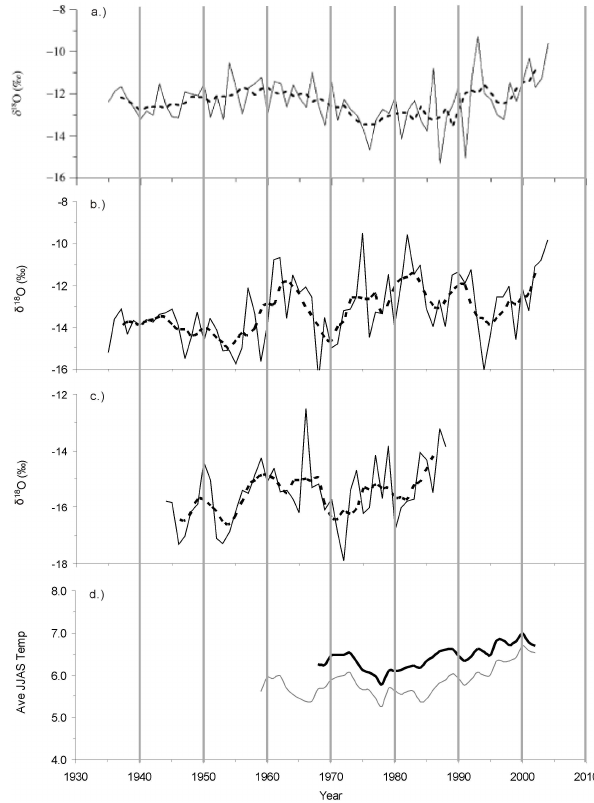
Fig. 4. (a) δ 18 O values from the Geladaindong ice core (Kang et al., 2007). Annual averages are depicted with solid lines, 5-yr running means with dashed lines. (b) Same as (a) for the TGL05 ice core. (c) Same as (a) for a previous Tanggula ice core (Yao et al., 1995); note the more depleted δ 18 O scale (d) Average JJAS temperatures recorded at Tuotuohe (black line) and Amdo stations (grey line).